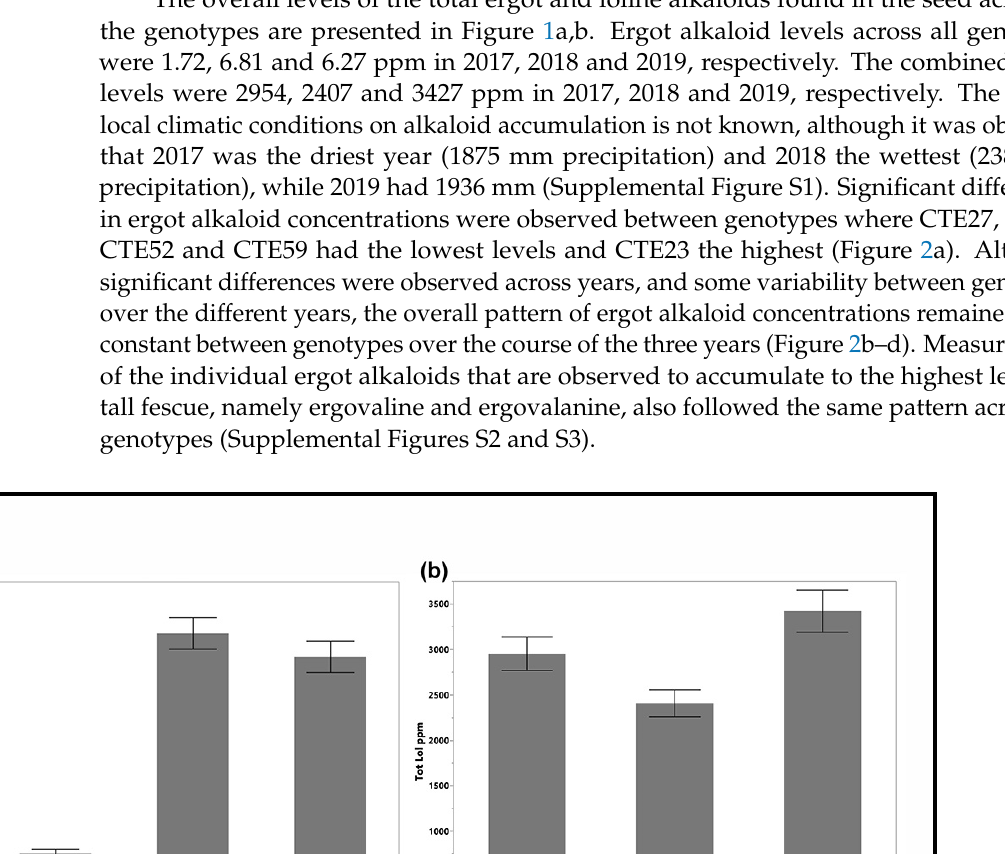
Figure 2. Seed head ergot alkaloid (Total EA) levels in 16 CTE tall fescue clones ( a ) averaged over three years of study, and for ( b ) 2017, ( c ) 2018 and ( d ) 2019 individually. Data are means +/ − 1 s.e. A similar genotypic difference was observed in the accumulation of loline alkaloids (Figure 3). Total loline levels across all years were seen to be lowest in CTE27, CTE46 and CTE63 and highest in CTE23, CTE28 and CTE58 (Figure 3a). This pattern was consistent across each year (Figure 3b–d). The levels of the different lolines varied based on geno- type (Figure 4a–c). Interestingly, CTE28 appears to have significantly lower levels of the loline alkaloid N-acetylloline (NAL) (Figure 4c). While the biosynthetic pathway from N-acetylnorloline (NANL) to NAL is still not known, it is postulated not to be fun- gal-derived, but produced via a plant acetyltransferase [33].